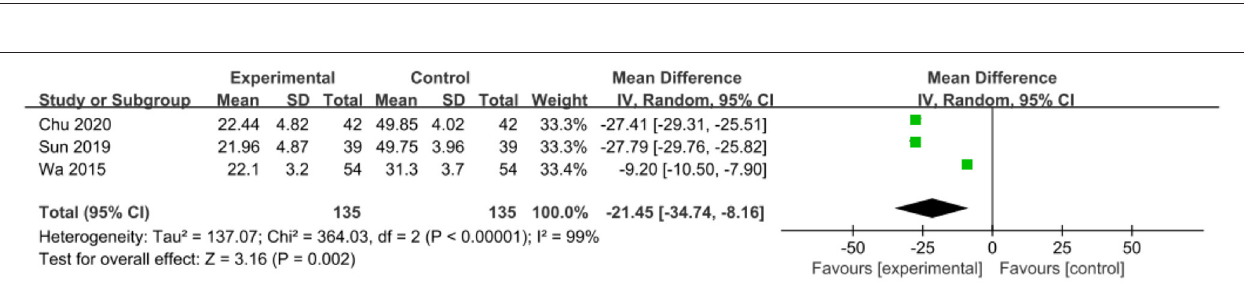
FIGURE 12 | Forest plots of AST associated with experimental group (parenteral or enteral nutrition group supplemented with Gln) vs. control group (conventional nutrition group). I 2 tests and P are the criteria for the heterogeneity test, (cid:7) , pooled mean difference; — (cid:4) —, mean difference, and the edges of (cid:7) , 95% CI.